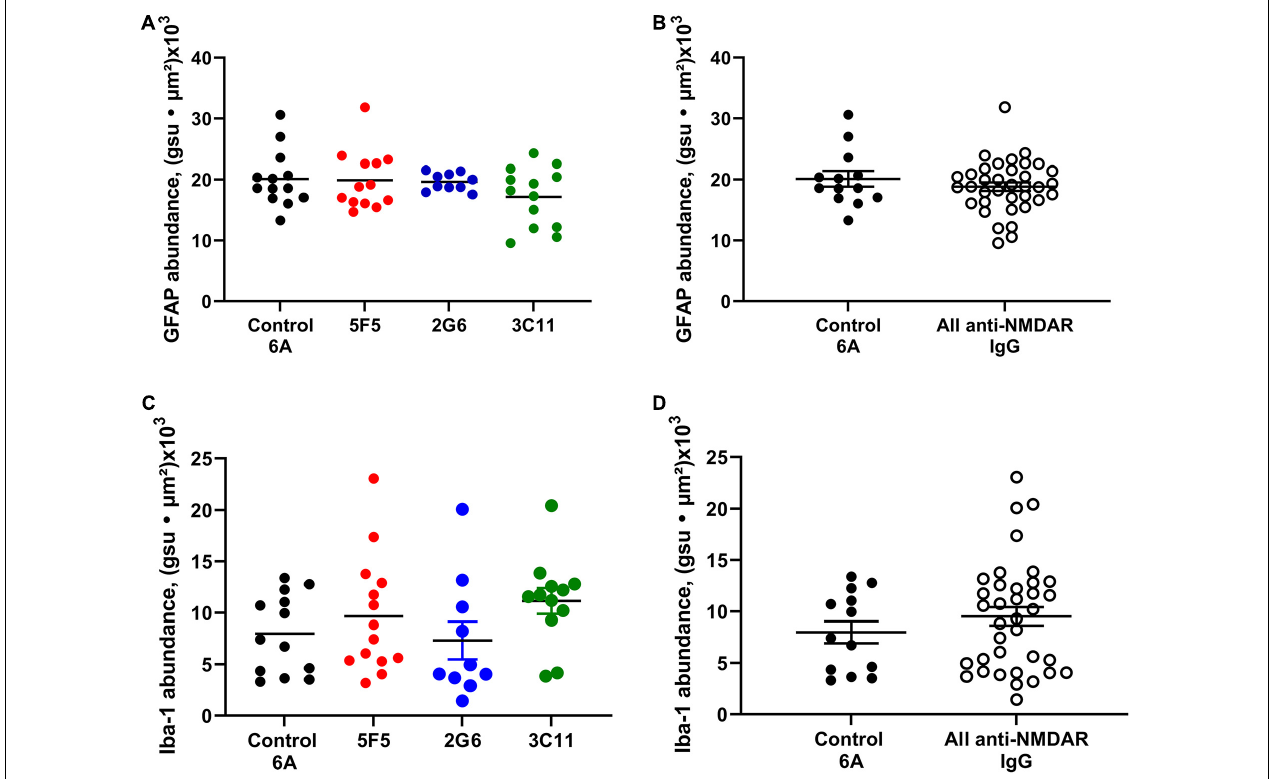
FIGURE 4 | Expression of astrocytic and microglial markers of inflammation in the CA1 region of hippocampus of mice with anti-NMDAR antibody-induced seizures. The expression of GFAP in 1X and 10 × 5F5, 2G6, or 3C11 antibody-treated mice (A) and combined antibody-treated mice (B) was similar to that in control 6A IgG-infused mice. The expression of Iba1 in 5F5, 2G6 or 3C11- antibody treated mice (C) and combined antibody-treated mice (D) was comparable in all groups and similar to that in control 6A IgG-infused mice. GFAP: n = 13 (control 6A IgG, black circles), n = 13 (5F5, red circles), n = 10 (2G6, blue circles), and n = 13 (3C11, green circles). Iba1: n = 13 (control 6A IgG), n = 14 (5F5), n = 10 (2G6), and n = 12 (3C11). The abundance of GFAP or Iba1 labeling in the CA1 region was determined as the sum of the products of mean pixel intensity (gray scale units, gsu) and area of each event ( µ 2 ) in a fixed scan area. The data are mean ±